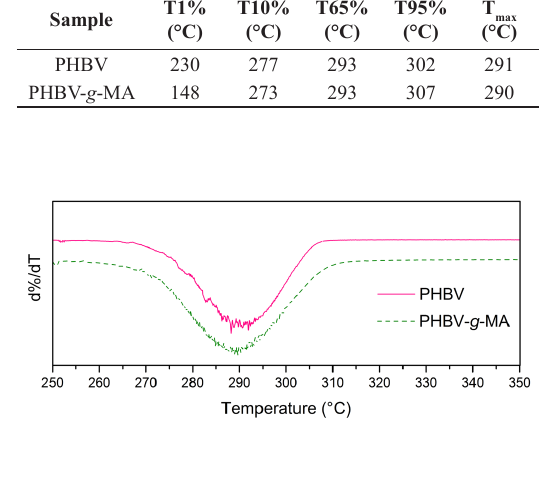
Figure 3. FTIR spectroscopy of neat PHBV and PHBV-g-MA in the region between 900 and 500